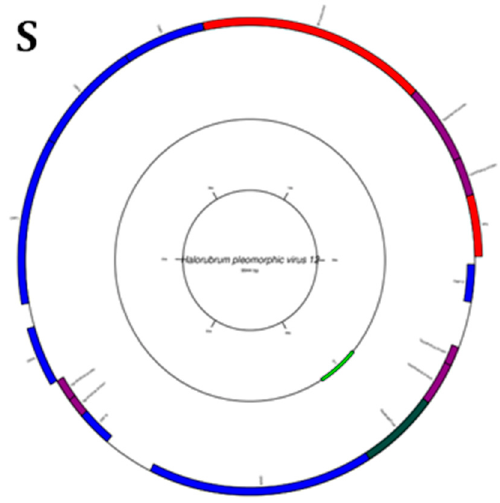
Figure 5. Diagrams of circular reference genome (outer circle) of metavirus, where the green segment represents query virus (s inner circle): ( A ) Myohalovirus chaoS9, ( B ) Halorubrum phage Cgphi46, ( C ) Archaeal BJ1 virus, ( D ) Betapleolipovirus HRPV3, ( E ) Myohalovirus PhiCh1, ( F ) Hal- ovirus HCTV-1, ( G ) Halorubrum virus HRTV-29, ( H ) Halovirus HSTV-1, ( I ) Betapleolipovirus HRPV9, ( J ) Halovirus HGTV-1, ( K ) Haloferax tailed virus 1, ( L ) Betapleolipovirus HHPV4, ( M ) My- ohalovirus phiH, ( N ) Haloarcula virus HCIV1, ( O ) Halovirus HRTV-4, ( P ) Alphapleolipovirus HRPV6, ( Q ) Alphapleolipovirus HRPV2, ( R ) Halovirus VNH-1, and ( S ) Betapleolipovirus HRPV12.